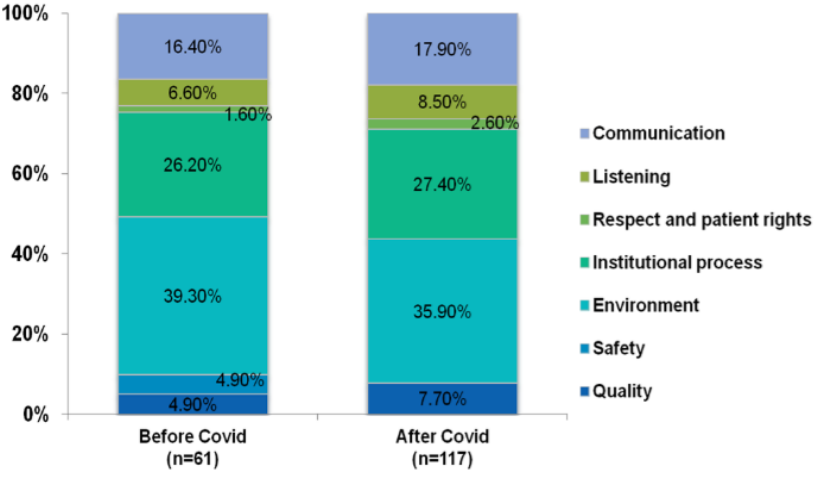
Figure 1. The healthcare complaints analysis tool domains and problems with COVID-19-related events before and during the COVID-19 pandemic (n =